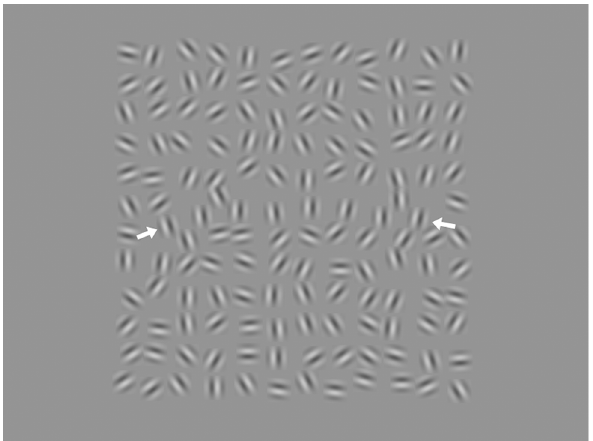
Fig 1. Target stimulus example. A 12x12 array of randomly oriented Gabor patches, eight of which are aligned along a curved path (ends marked here by white arrows). The aligned patches constitute a 'ladder contour', which is very difficult to perceive in peripheral vision. The image displayed here, including the gray surround, is the same (proportionally) as that shown on the experiment display.